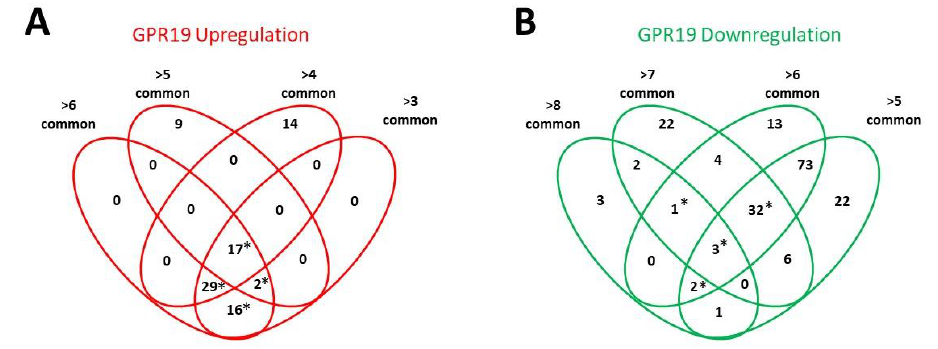
Figure 2. WikiPathway signaling analysis of GPR19-associated proteins. Using protein lists assembled from the GEO GPR19 upregulated cohort (proteins used were from the common to >3, >4, >5 and >6 sub-lists derived from the primary data list) or the GPR19 downregulated cohort (proteins used were from the common to >5, >6, >7 and >8 sub-lists derived from the primary data list) were subjected to WikiPathways signaling pathway enrichment analysis. For a pathway to be significantly enriched, an enrichment probability of <0.05 was required using at least two independent proteins. Venn diagrams of the enriched pathways derived from the differing GPR19 upregulated ( A ) or GPR19 downregulated ( B ) proteins were created. Pathways found in at least three out of the four (indicated by an asterisk, *) different initial datasets were then used for further analyses of their quantitative and qualitative enrichment